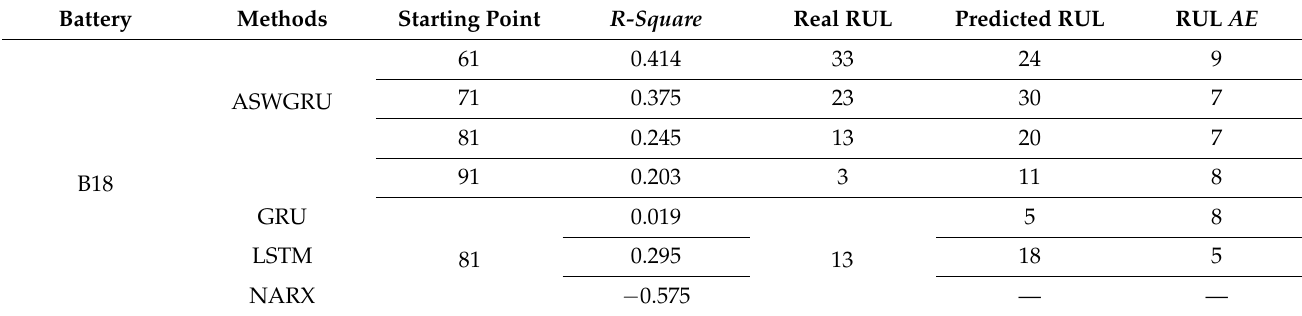
Table 6. The obtained results with different prediction start points for